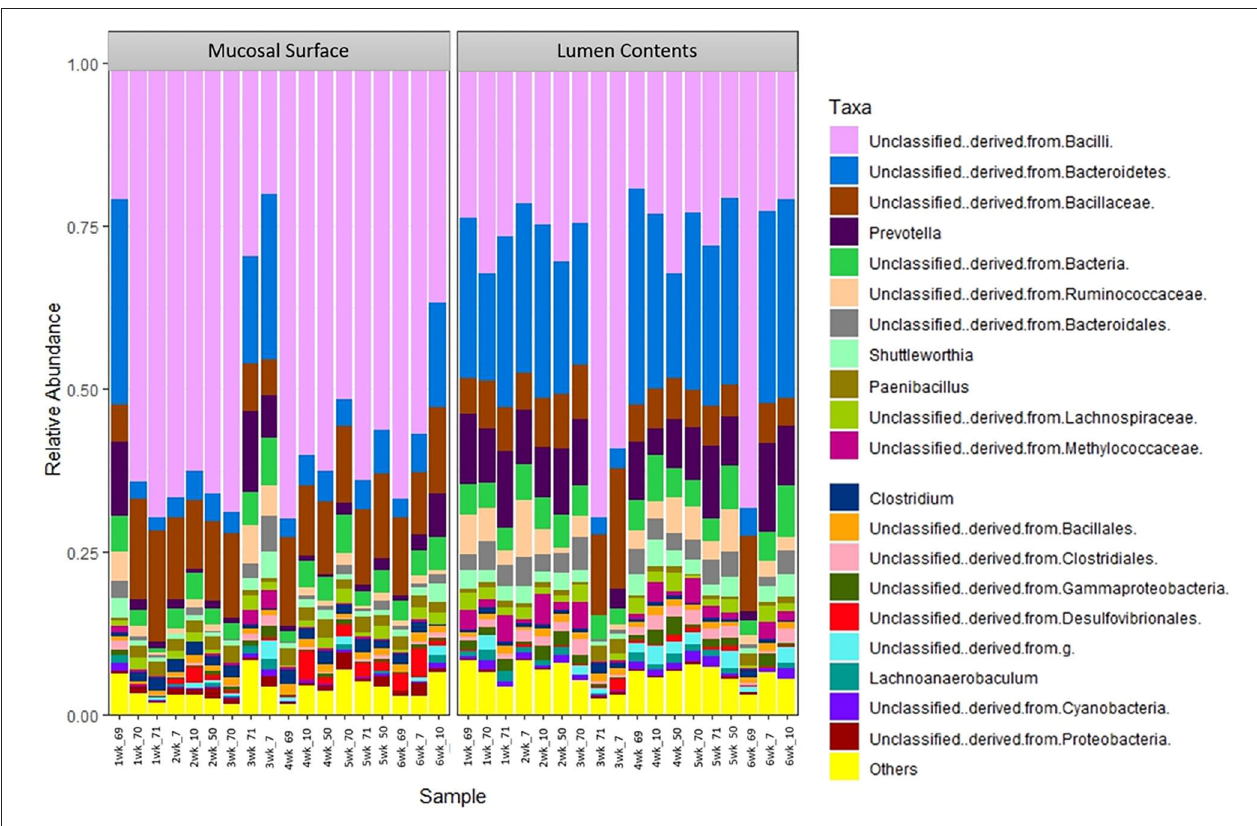
FIGURE 7 | Bacterial genus. Stacked bar chart representing the abundance of the microbiota at the genus taxonomic level in the mucosal biopsy surface and lumen contents across the sampled weeks for each